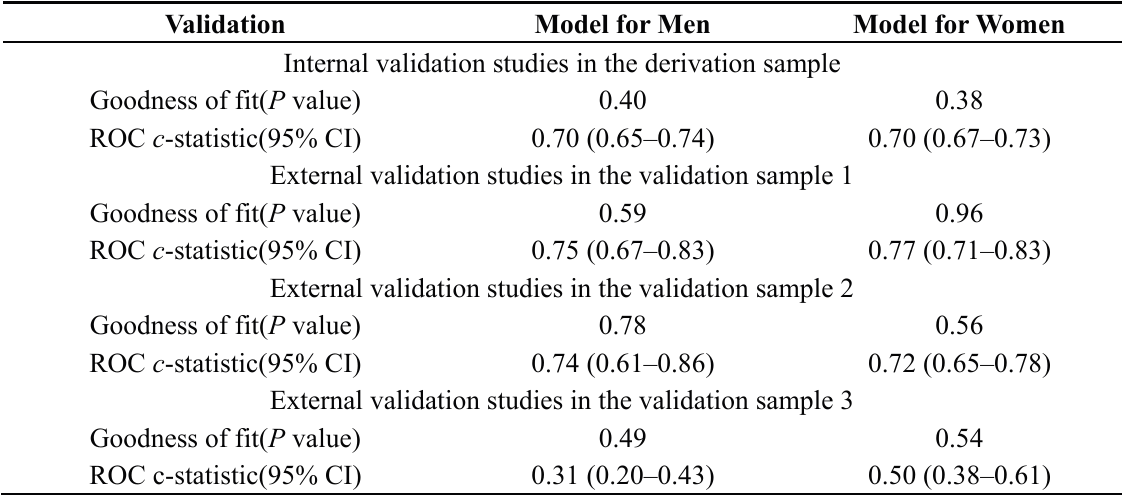
Table 3. Internal and external validation studies of the different